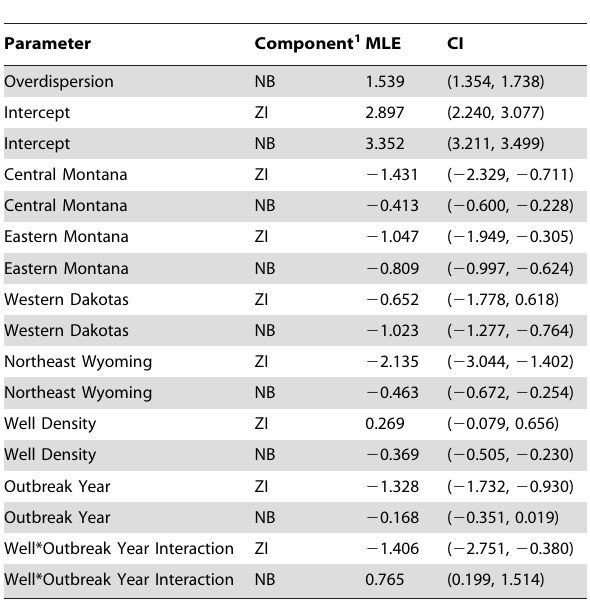
Table 3. Maximum likelihood estimates and profile likelihood confidence intervals for parameters of the reduced